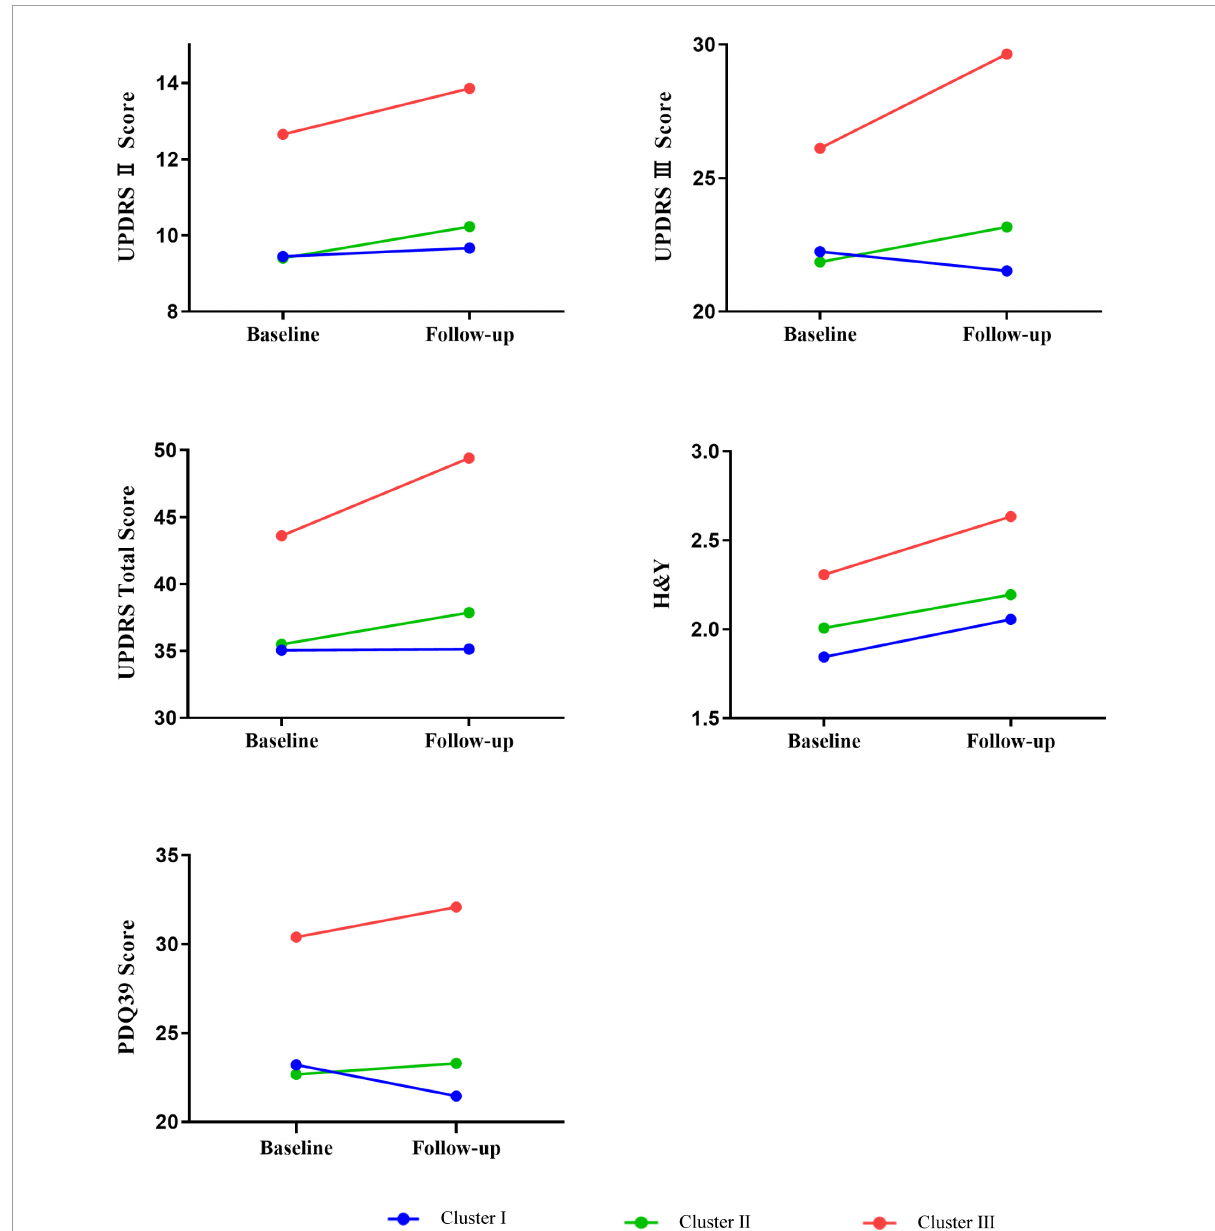
FIGURE2 Longitudinal changes in outcomes of interest in different phenotypes of EOPD at follow-up. In each general linear models, change of clinical characteristics was defined as the dependent variable, and was adjusted by the follow-up duration and baseline value of clinical factors. Mean follow-up duration in the entire population = 1.5 years. UPDRS, Unified Parkinson’s disease Rating Scale; H&Y, Hoehn and Yahr; PDQ-39, Parkinson’s disease questionnaire-39 item